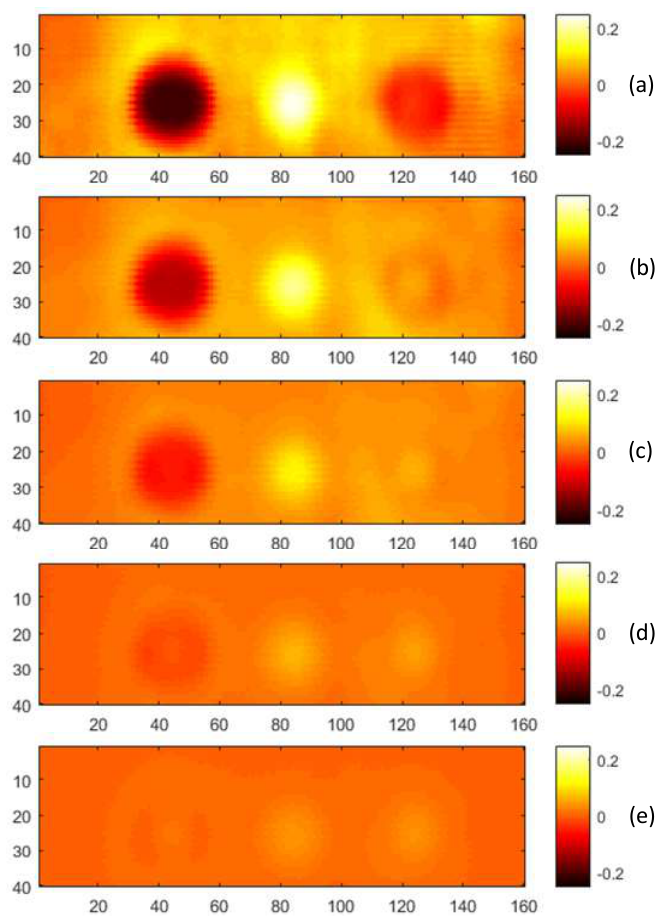
Figure 22. Conducting specimen covered with an insulation layer with three defects. The scans were taken with minimal lift-off, 0.5, 1, 1.5 and 2 mm lift-offs. During the CI scans, the aluminium board was grounded. The measured values were also transformed into the NVRs , which were used to form capacitive images, as shown in Figure 23. For direct comparison, the images are plotted in the same colour range.